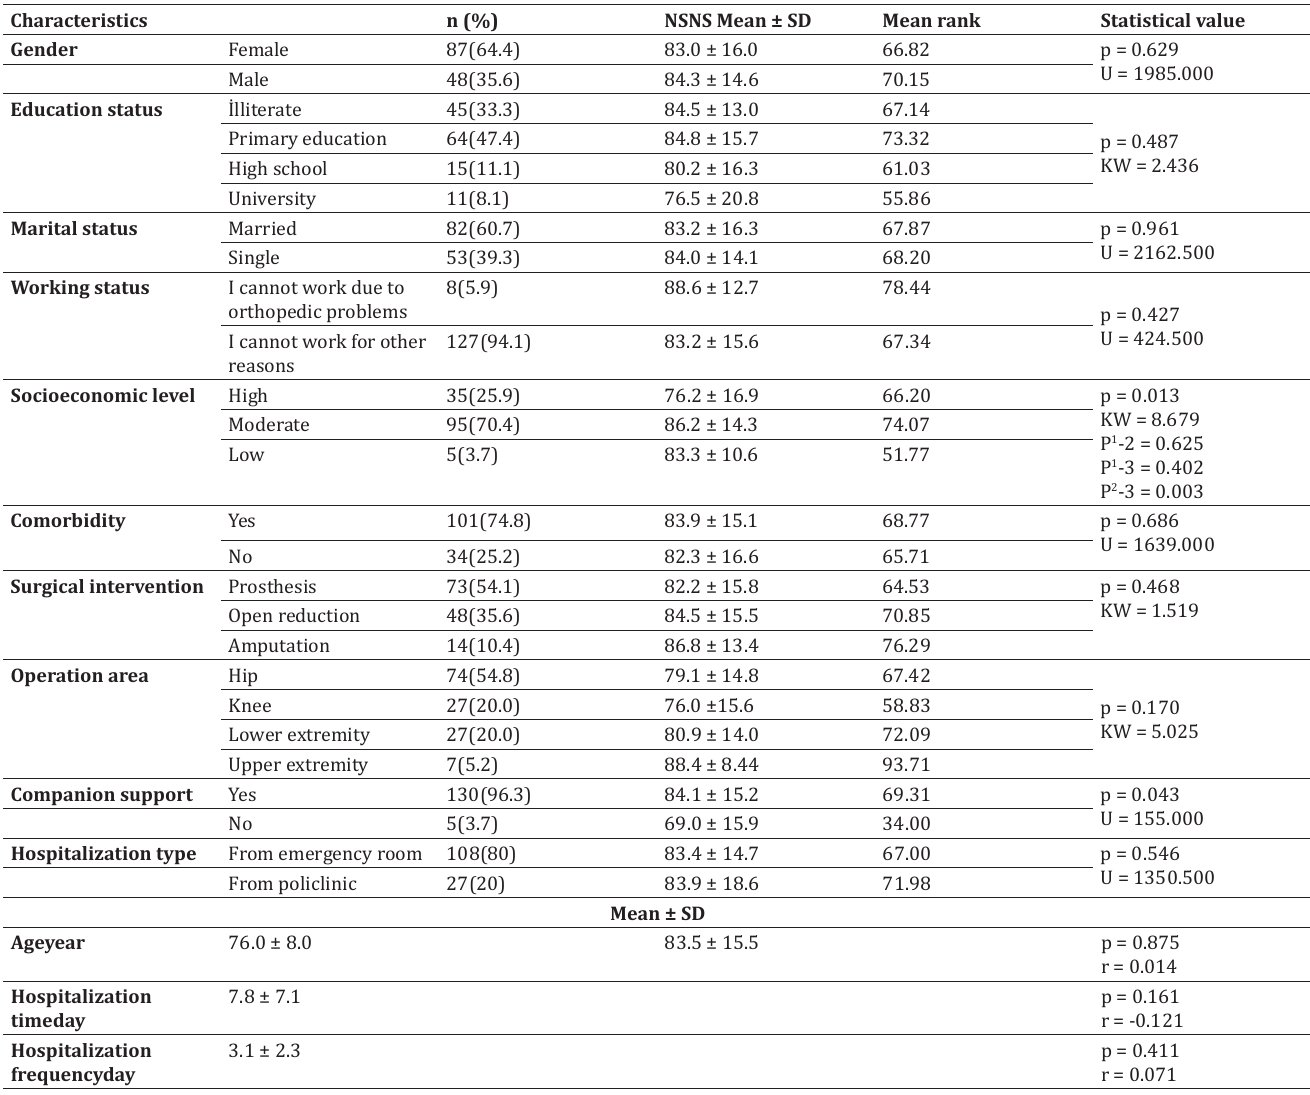
Patients’ Sociodemographic Characteristic (n = 135) Characteristics